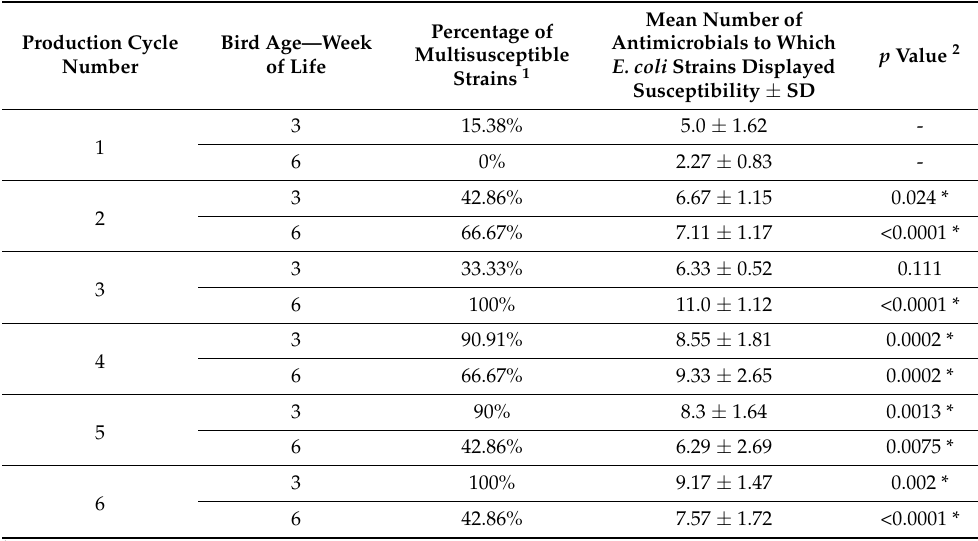
Table 2. Summarized results of E. coli antimicrobial susceptibility testing from experiment 1.